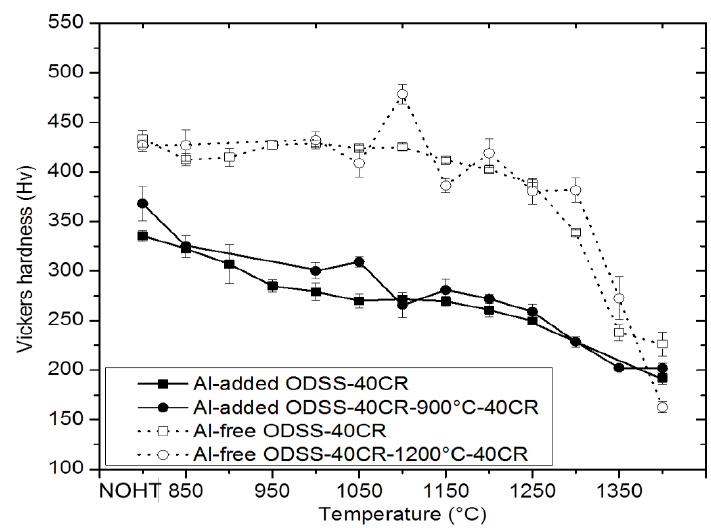
Figure 11. The effect of prior treatment of 40%CR + recrystallization annealing on the Vickers hardness changes by isothermal annealing for 1 h at each temperature from 850 °C to 1400 °C, with 50 °C step for both the 15Cr-ODS steels with and without Al addition (see Figure 3), where the prior annealing temperature was selected to be 900 °C in Al-added ODS steel and 1200 °C in Al-free ODS steel. NOTH stands for no heat treatment.